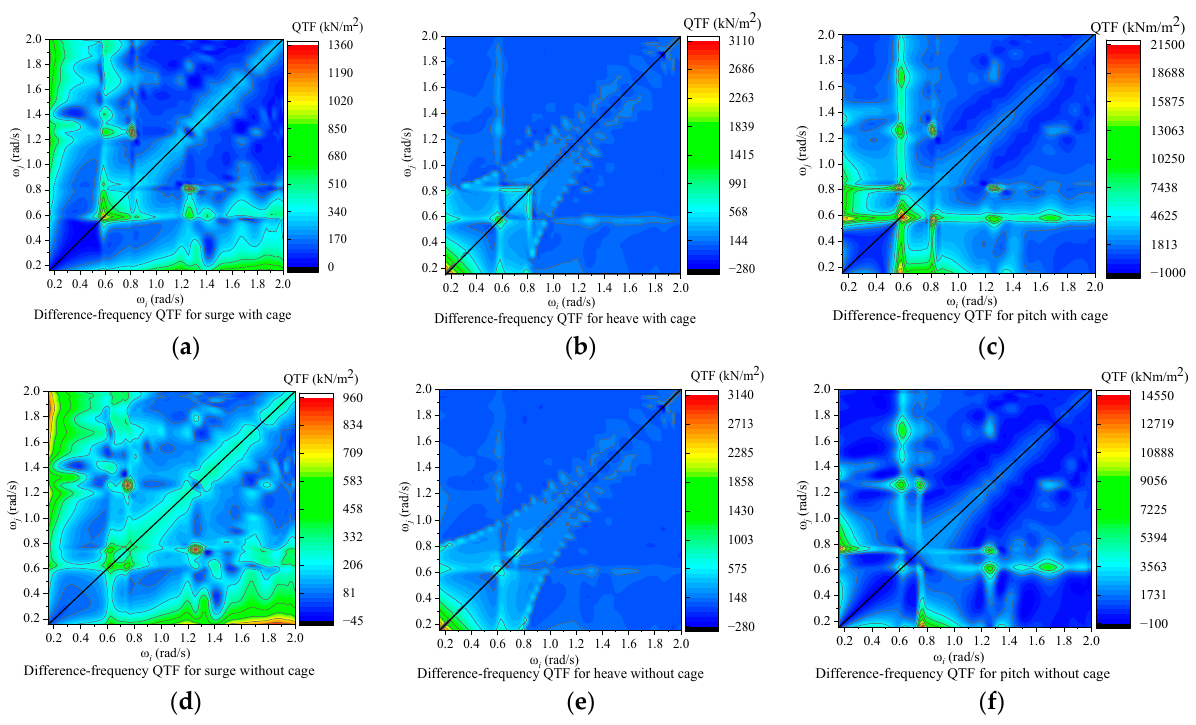
Figure 11. Second-order difference-frequency QTFs of the barge-type FOWT-AC and barge-type FOWT for a zero-degree wave heading: ( a ) Surge of FOWT-AC; ( b ) Heave of FOWT-AC; ( c ) Pitch of FOWT-AC; ( d ) Surge of FOWT; ( e ) Heave of FOWT; ( f ) Pitch of FOWT.